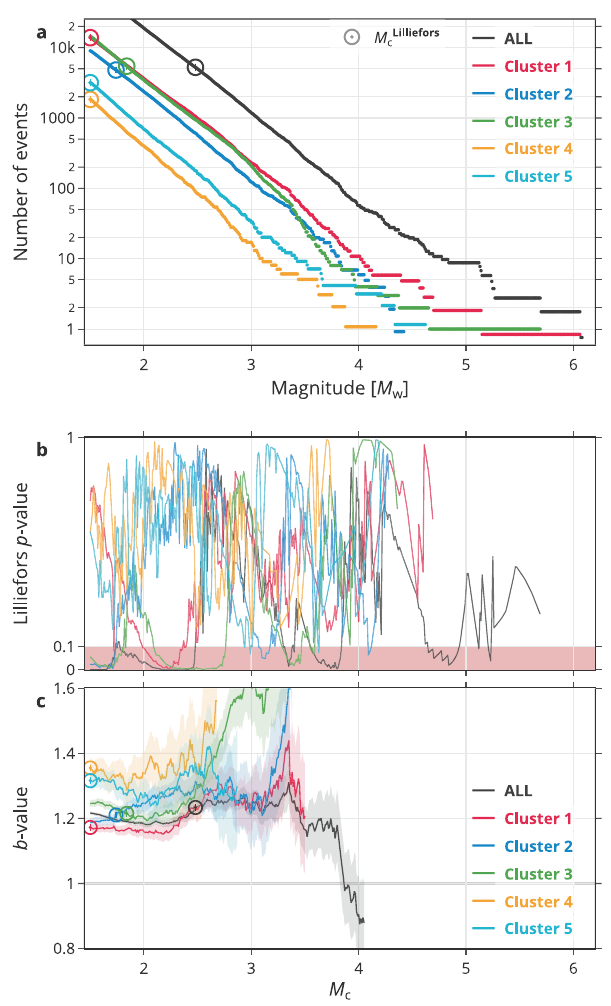
Fig. 3 | Magnitude statistics for all data (black) and individual clusters (see legend). a Representing the data in terms of their magnitude – frequency distribu- tion (MFD). Note that a tiny value is added to each MFD (between − 0.1 and 0.1) to avoid visual overlaps at large magnitudes. b The Lilliefors p -value (assuming an exponential distribution as null hypothesis) as a function of lower magnitude cutoff, or magnitude of completeness, M c (see Methods). c The estimated b -value (the slope of the fi tted Gutenberg – Richter relation, see Methods) as a function of σ . The M Lilliefors M c with the shading representing 1 c estimates are indicated for each clusterin a and c withacirclemarker.SupplementaryFig.3showsthesameanalysis using local